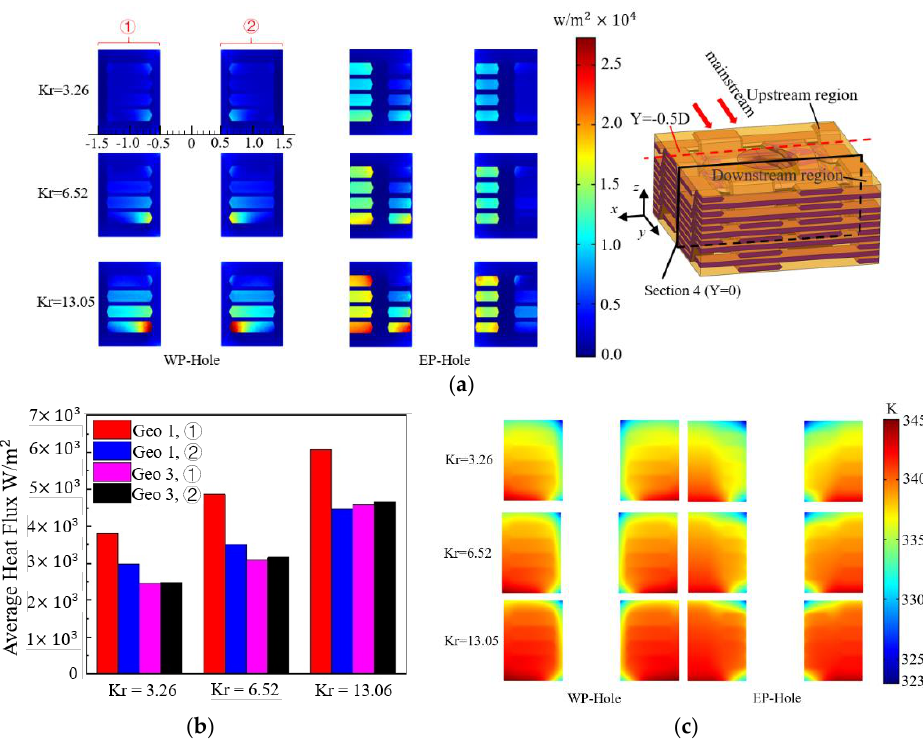
Figure 16. Heat flux and temperature field on section 4 of the different cases: ( a ) heat flux at Y component on section 4 of different cases, ( b ) histogram of average heat flux, and ( c ) temperature field on section 4 of different cases.